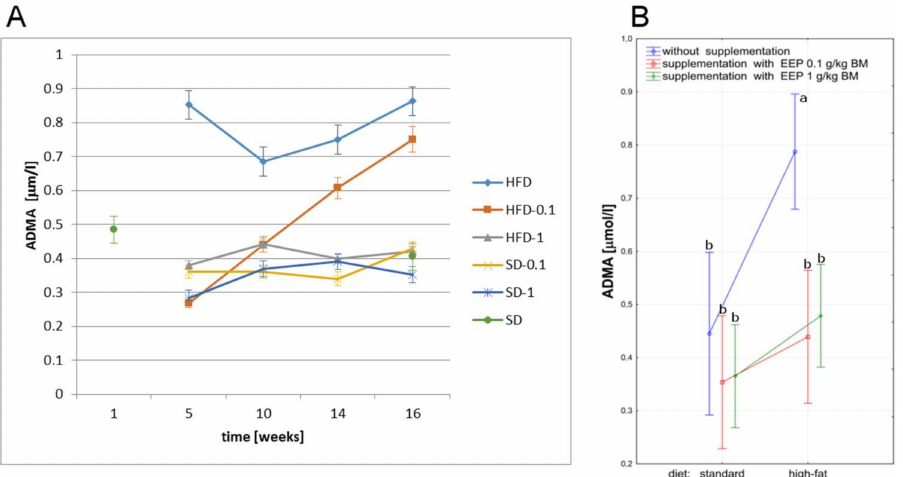
Figure 5. Asymmetric dimethylarginine level in C 57 BL 6 mice. ( A ) ADMA level in particular weeks